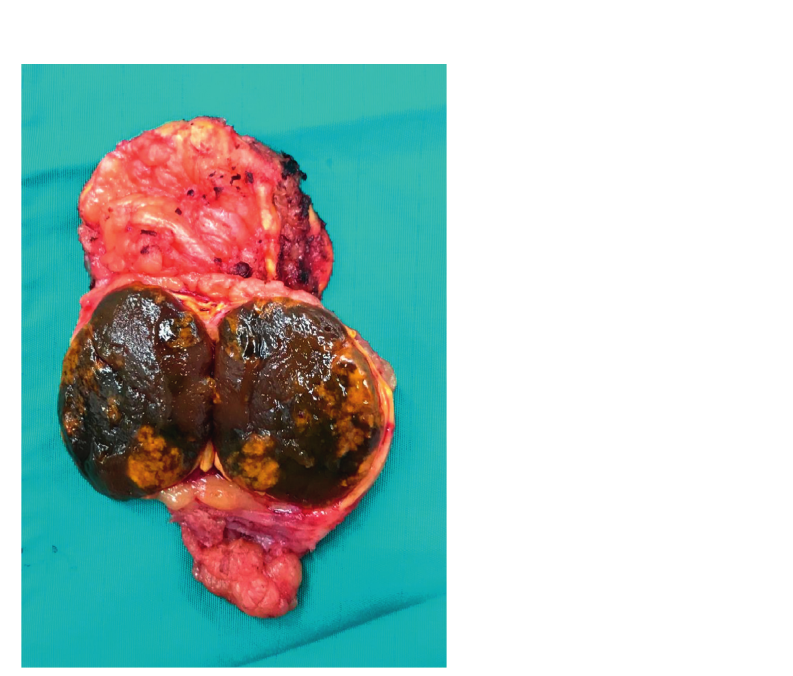
Figure 1: Macroscopic specimen: tan-brown neoplasm with regular and smooth borders largely replacing the normal adrenal gland parenchyma, which is recognizable at the margin of the specimen.